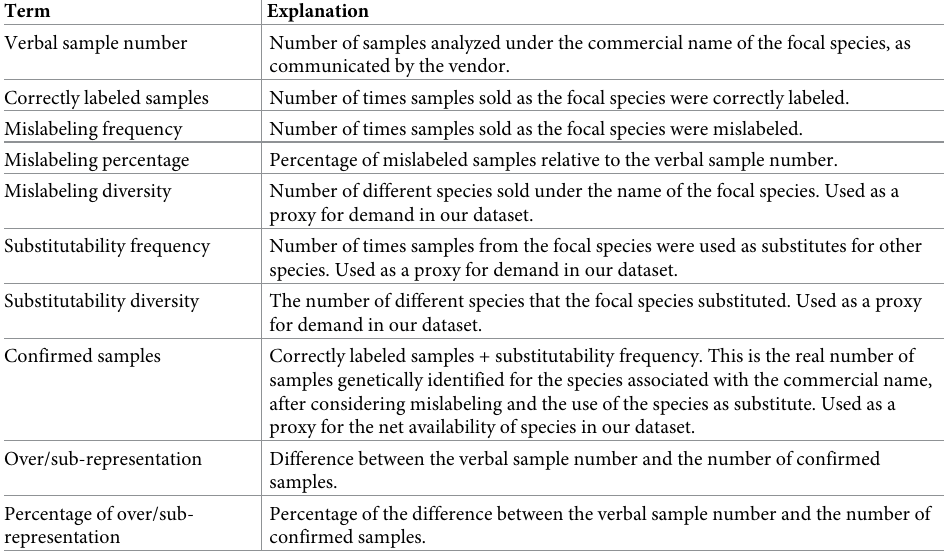
Table 1. The terminology used in the analyses of seafood mislabeling and substitution, following Munguia-Vega et al.